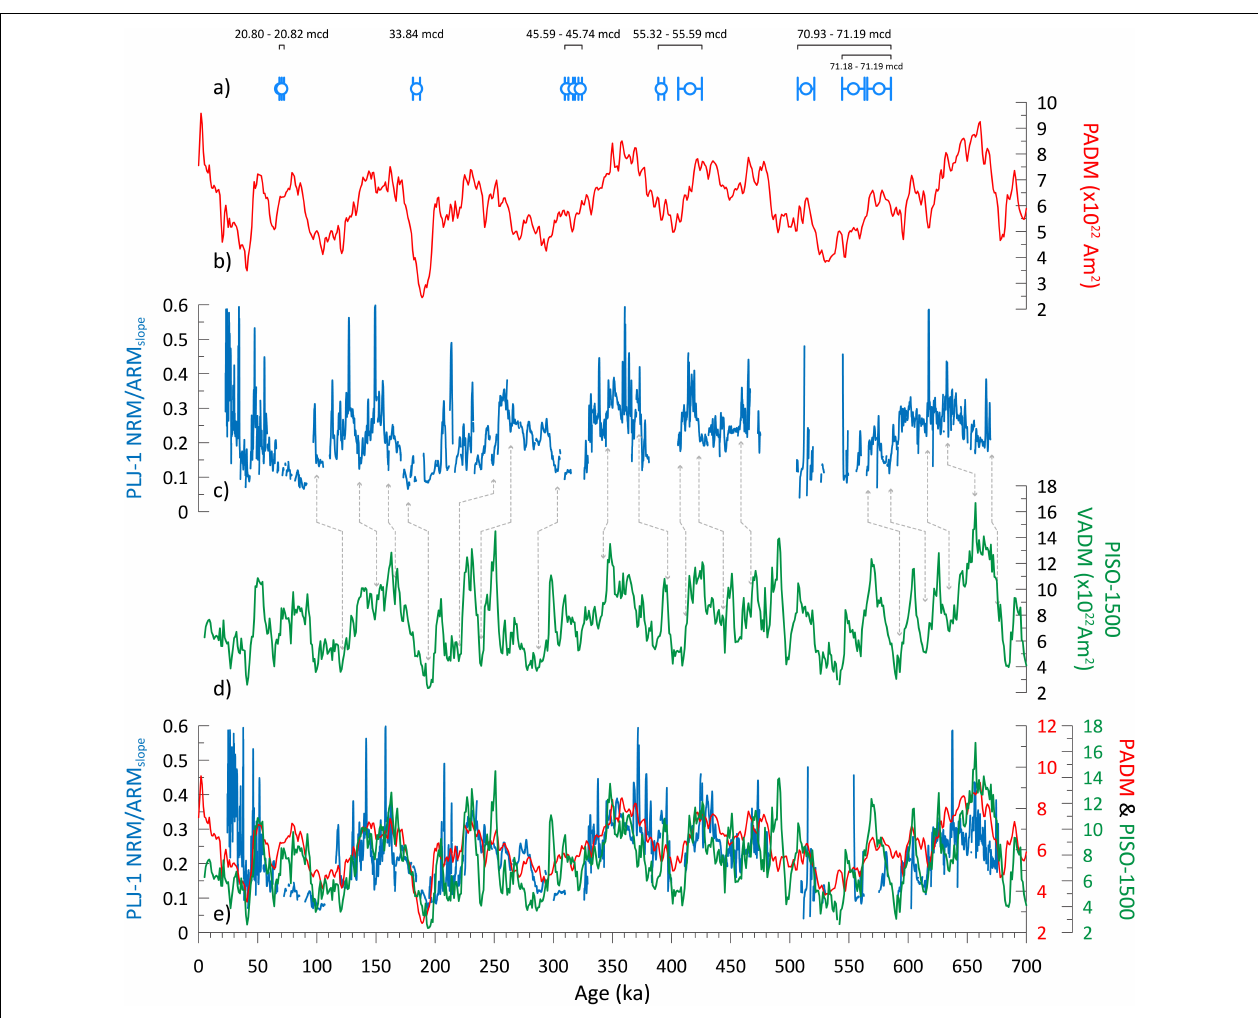
FIGURE 8 | (a) The 12 U-Th age constraints and 1-sigma uncertainty from the five horizons used to construct the age-depth model of Chen et al. (2020); the depth ranges of the dated samples are also given. (b) PADM-2M (red) dipole moment model of Ziegler et al. (2011). (c) The filtered Lake Junín H-NRMint NRM/ARM slope RPI estimate (blue) using the age model of Chen et al. (2020). (d) PISO-1500 (green) RPI stack of Channell et al. (2009). Gray dashed lines between the Junín record and the PISO-1500 RPI stack is used to improve the correlation between the two from r = 0.15 to r = 0.51. (e) Comparison of PADM-2M, PISO-1500, and Junín RPI estimate after age adjustment using the gray tie-points. Correlation is restricted to the period prior to 120 ka (see text for further